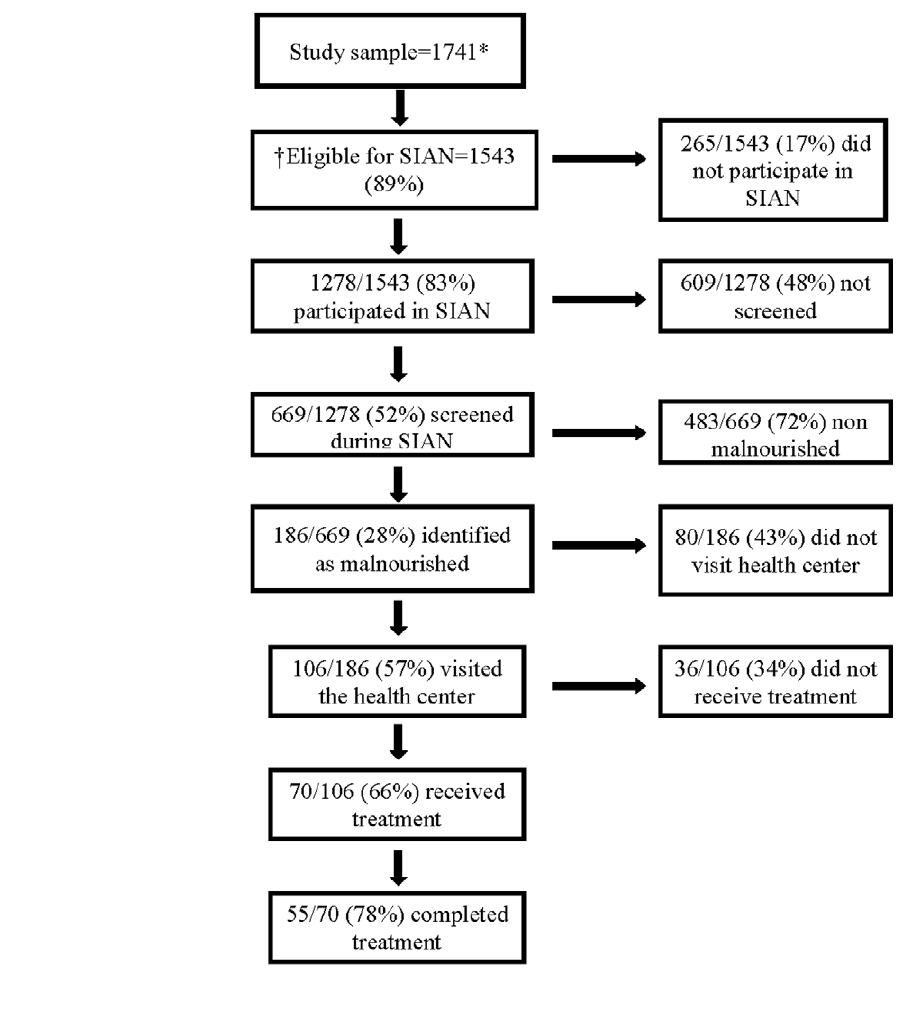
Figure 1. Outcome of screening during SIAN.